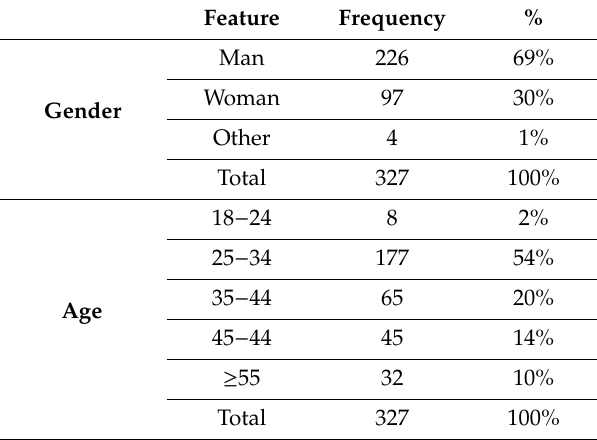
Table 1. Sample features Men / Women / Other.